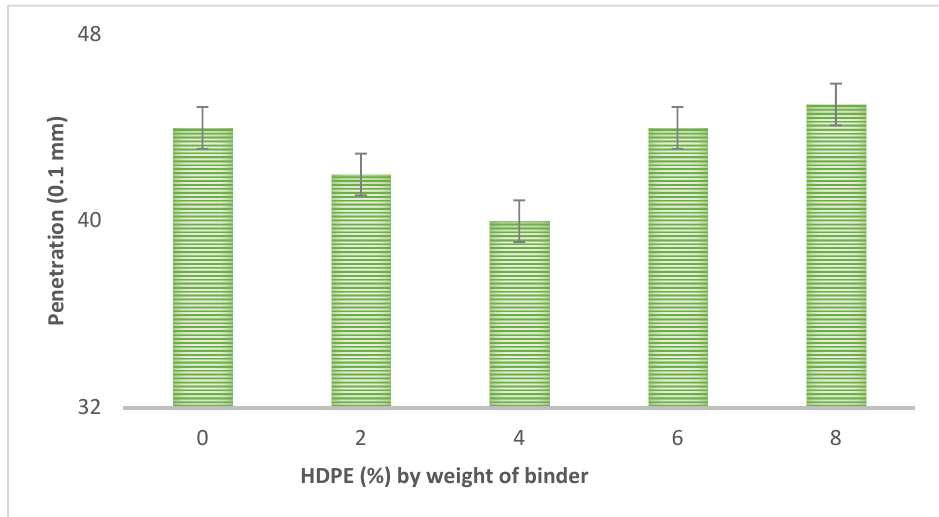
Figure 4. Results for the penetration of unaged HDPE-modified bitumen.